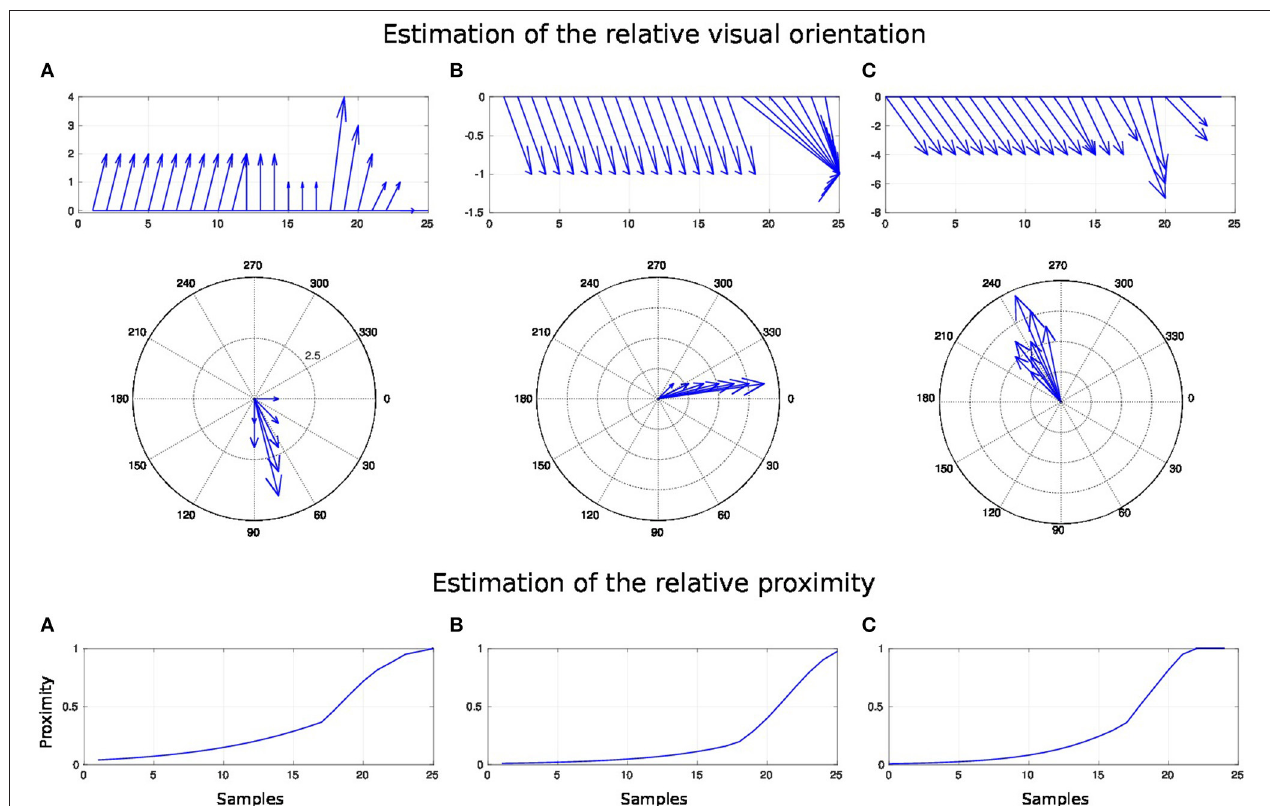
FIGURE 13 | Spatial receptive fields and relative visual orientation of arm-centered GF neurons for three approaching targets. The bottom charts correspond to the estimated proximity of three arm-centered GF neurons respectively at locations (A–C) . The y axis corresponds to the amplitude level of the neurons and the x axis correspond to time iteration. The higher the amplitude level of the GF neurons is, The closer the target is with respect to the arm location. Each GF neuron has a different types of receptive field with respect to the arm part and the receptive fields are different from the target-centered GF neurons displayed in Figure 11 . The middle and top charts represent the estimated relative visual orientation between the target and the robot arm. The density distribution of the estimated visual orientation is affined during displacement of the target toward the arm.